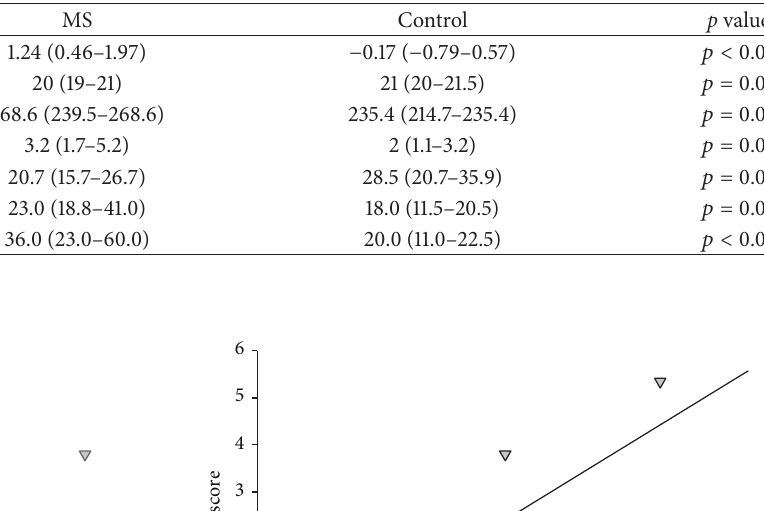
Table 2: Result of physiological profile assessment of the MS and control groups.